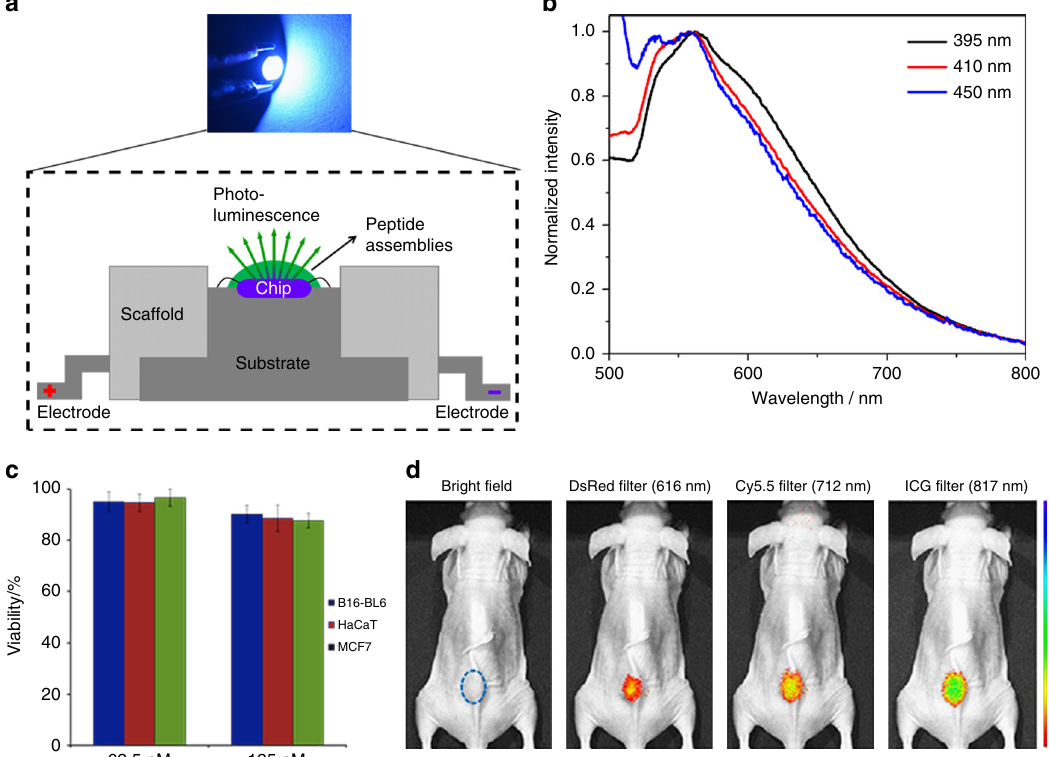
Fig. 6 Application of the cyclo-WW + Zn(II) QC self-assemblies. a Schematic presentation of the LED setup using dried cyclo-WW + Zn(II) assembled in MeOH as phosphors. The upper inset shows the working depiction of a prototype, emitting bright green light (ex: 450 nm). b Spectroscopic characterization of the LED photoluminescence using three excitation wavelengths, as indicated, showing the same emission at 550 nm. c Cytotoxicity test of the cyclo-WW + Zn(II) nanospheres in DMSO (62.5 nM and 125 nM) towards B16-BL6, HaCaT, and MCF7 cells. Viability relative to untreated controls ± sd, designated as error bars, is shown based on three repeats and averaged. d In vivo whole body NIR fl uorescent imaging following subcutaneous injection of the nanospheres (50 μ L, 2.7 mM) into nude mice, showing notable emissions under various excitations. The dotted circle indicates the location of